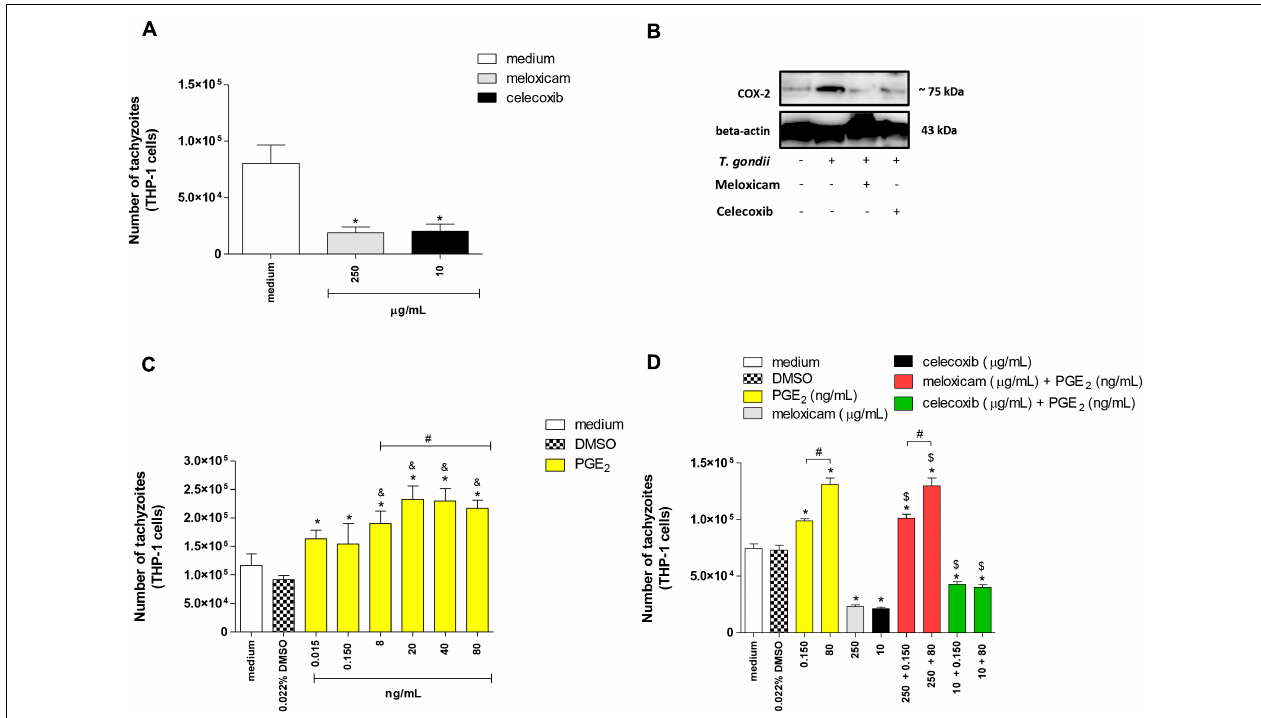
FIGURE 6 | Number of tachyzoites and COX-2 expression in THP-1 cells treated with COX-2 inhibitors and/or PGE 2 . THP-1 cells were seeded in 96-well plates (3 × 10 4 cells/200 µ L) for 24 h, infected with T. gondii tachyzoites (2F1 clone, RH strain), treated or untreated with meloxicam or celecoxib for additional 24 h, and submitted to T. gondii intracellular proliferation assay by β -galactosidase colorimetric reaction (A) . In parallel, THP-1 cells (1 × 10 6 cells/2000 µ L in 6-well plates) were infected or not and treated or not with meloxicam or celecoxib in RPMI medium during 24 h. Then, THP-1 cells were lysed and submitted to Western blotting for COX-2 and beta-actin detections (B) . After, THP-1 cells (3 × 10 4 cells/200 µ L in 96-well plates) were infected (2F1 clone) and treated with several concentrations of PGE 2 for additional 24 h (C) , or THP-1 cells were infected and treated with meloxicam or celecoxib plus PGE 2 for 24 h (D) , and all conditions submitted to T. gondii intracellular proliferation assay by β -galactosidase colorimetric reaction. DMSO (0.022%) was used to exclude any effect of DMSO in the parasitism. Data are shown as mean ± SEM of the number of tachyzoites from two independents experiments with eight replicates. Differences between groups were analyzed by one-way ANOVA with the Bonferroni multiple comparison post hoc test. Significant differences in relation to untreated/infected cells (medium) or infected/DMSO-treated cells ( ∗ P < 0.05, A,C,D ), between 0.015 or 0.150 ng/mL and 8–80 ng/mL PGE 2 ( & P < 0.05, C ), between different concentrations of PGE 2 or meloxicam plus PGE 2 ( # P < 0.05, C,D ), and between COX-2 inhibitors plus PGE 2 and respective control (infected and meloxicam or celecoxib-treated cells) ( $ P < 0.05, D